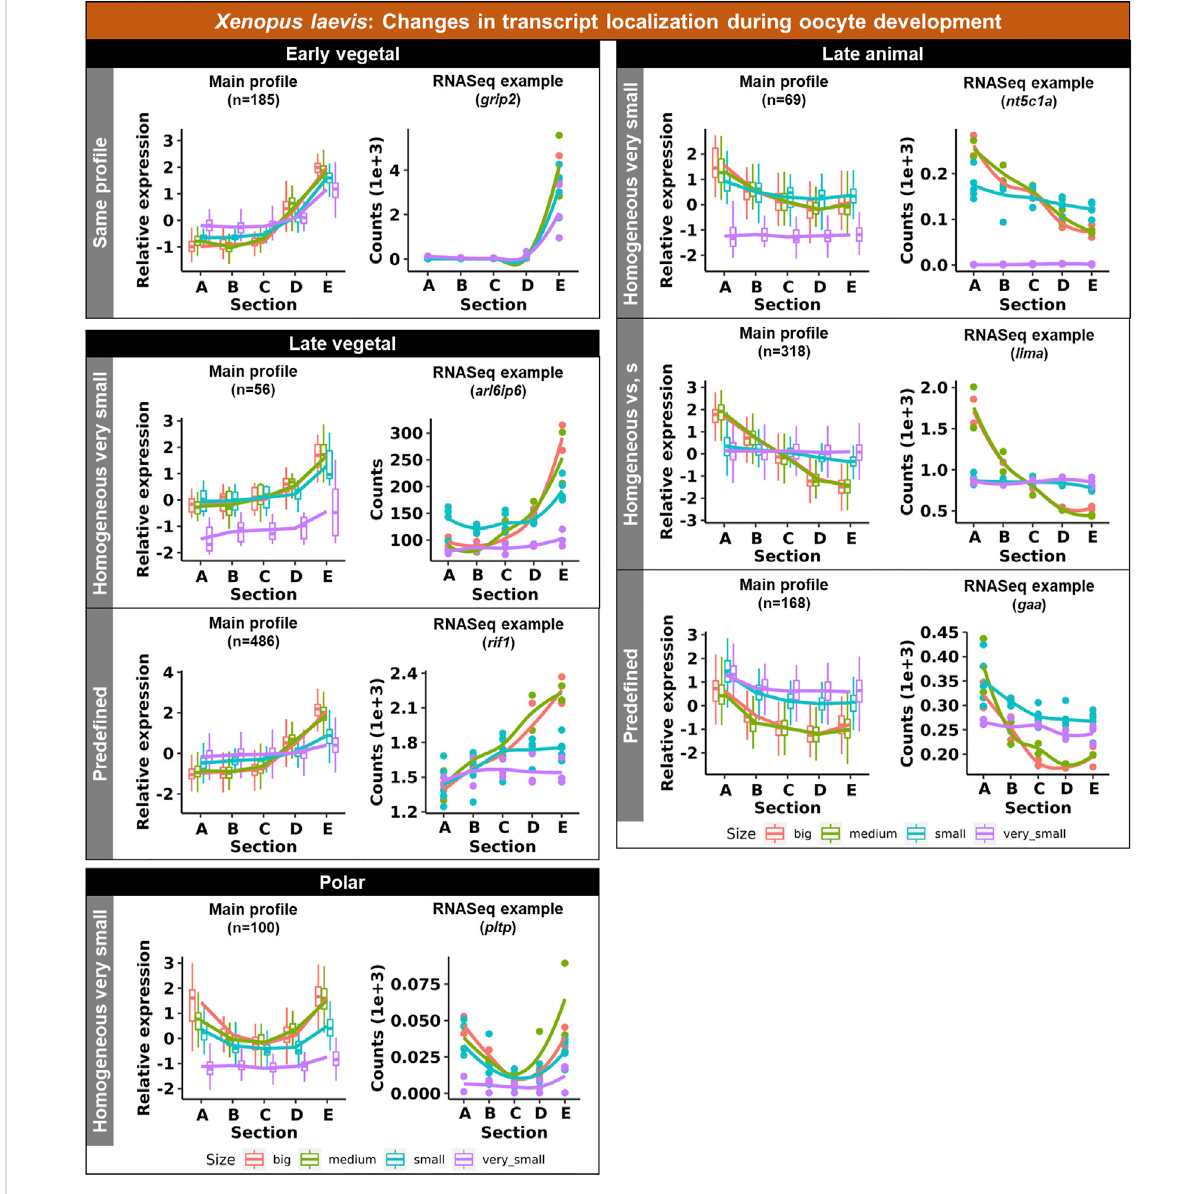
FIGURE 4 Unique groups representing the signi fi cant transcript sub-cellular alterations between the different oocyte sizes of the Xenopus laevis. Four groups of localization pro fi les were observable, early vegetal, late vegetal, late animal and polar. The following subgroups were observed: same pro fi le - similar pro fi le in early and late stages; prede fi ned - pro fi le already established in the early stages; homogeneous very small/small - pro fi le is ubiquitous in the small/very small stage; homogeneous vs., s - pro fi le is ubiquitous in both the small and very small stage. The sections correspond to the regions of the oocyte that were cryosectioned, whereby sections A - extremely animal, B - animal, C - central, D - vegetal, E - extremely